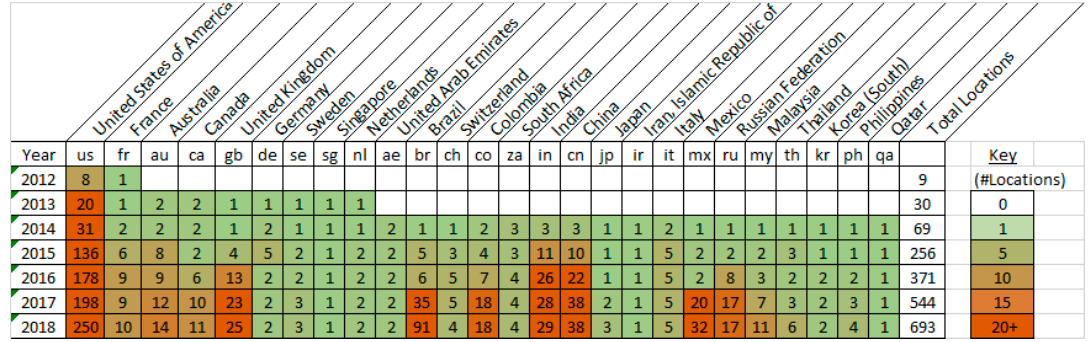
Figure 14. Uber availability (cities per country) 2012–2016 (tabulated).